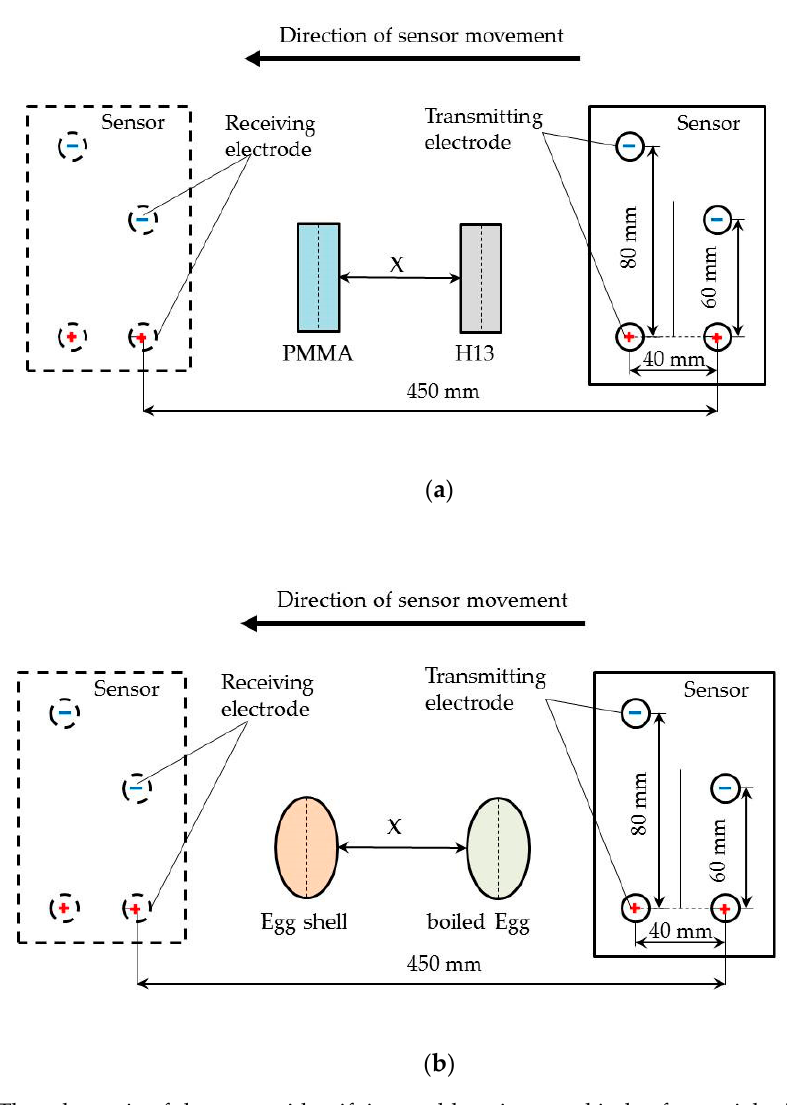
Figure 4. The schematic of the sensor identifying and locating two kinds of materials. The sensor passed above the identified objects along the X axis, ( a ) Schematic of the H13 and PMMA identification test; ( b ) Schematic of eggshell and boiled egg identification test.